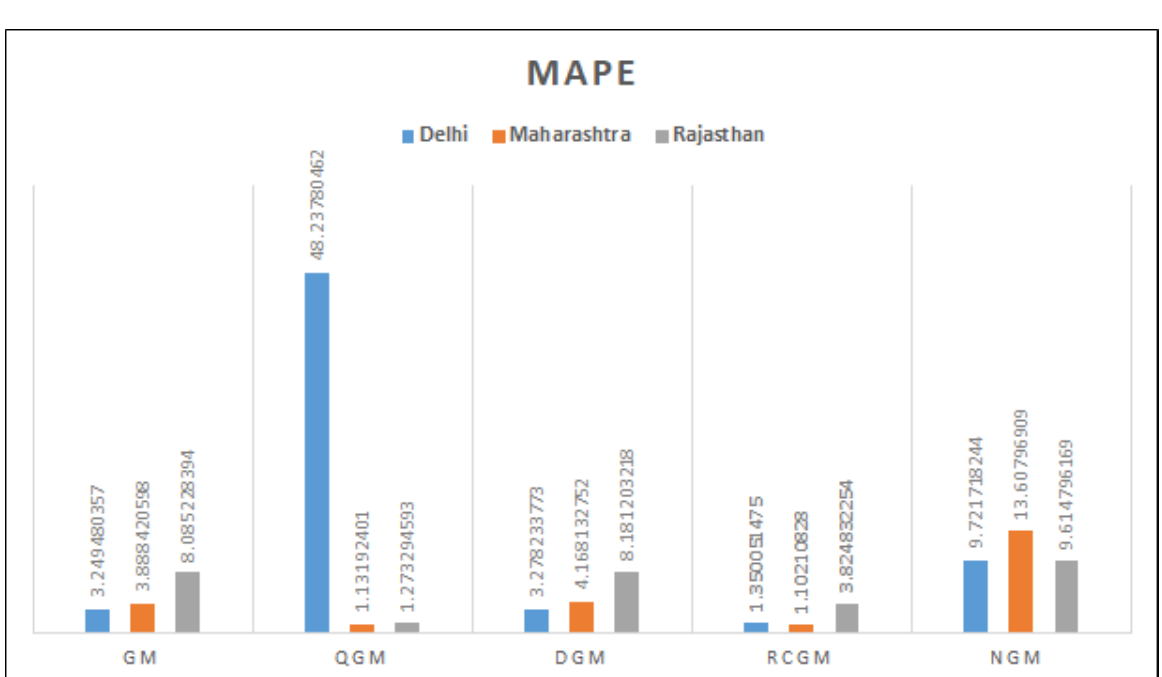
Figure 3. Forecasting Results-MAPE for